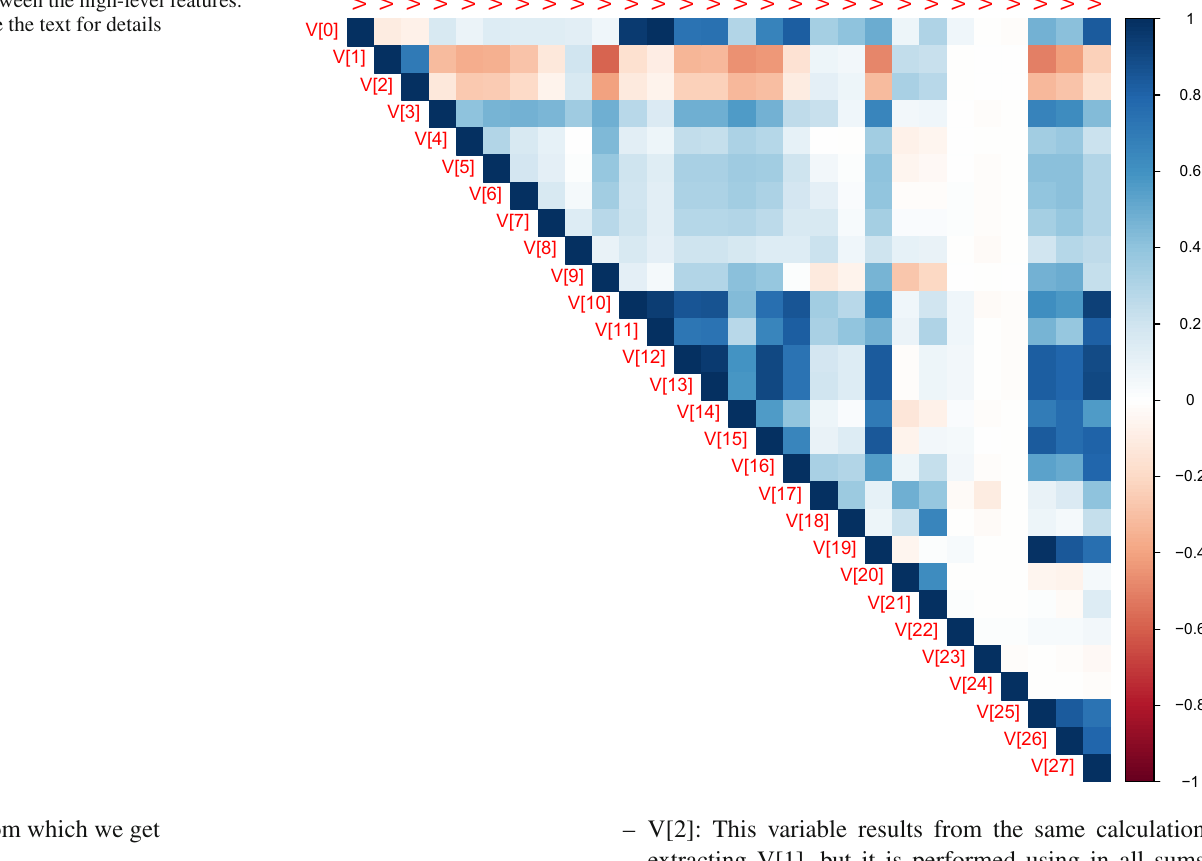
Fig. 21 Correlation matrix between the high-level features. See the text for details